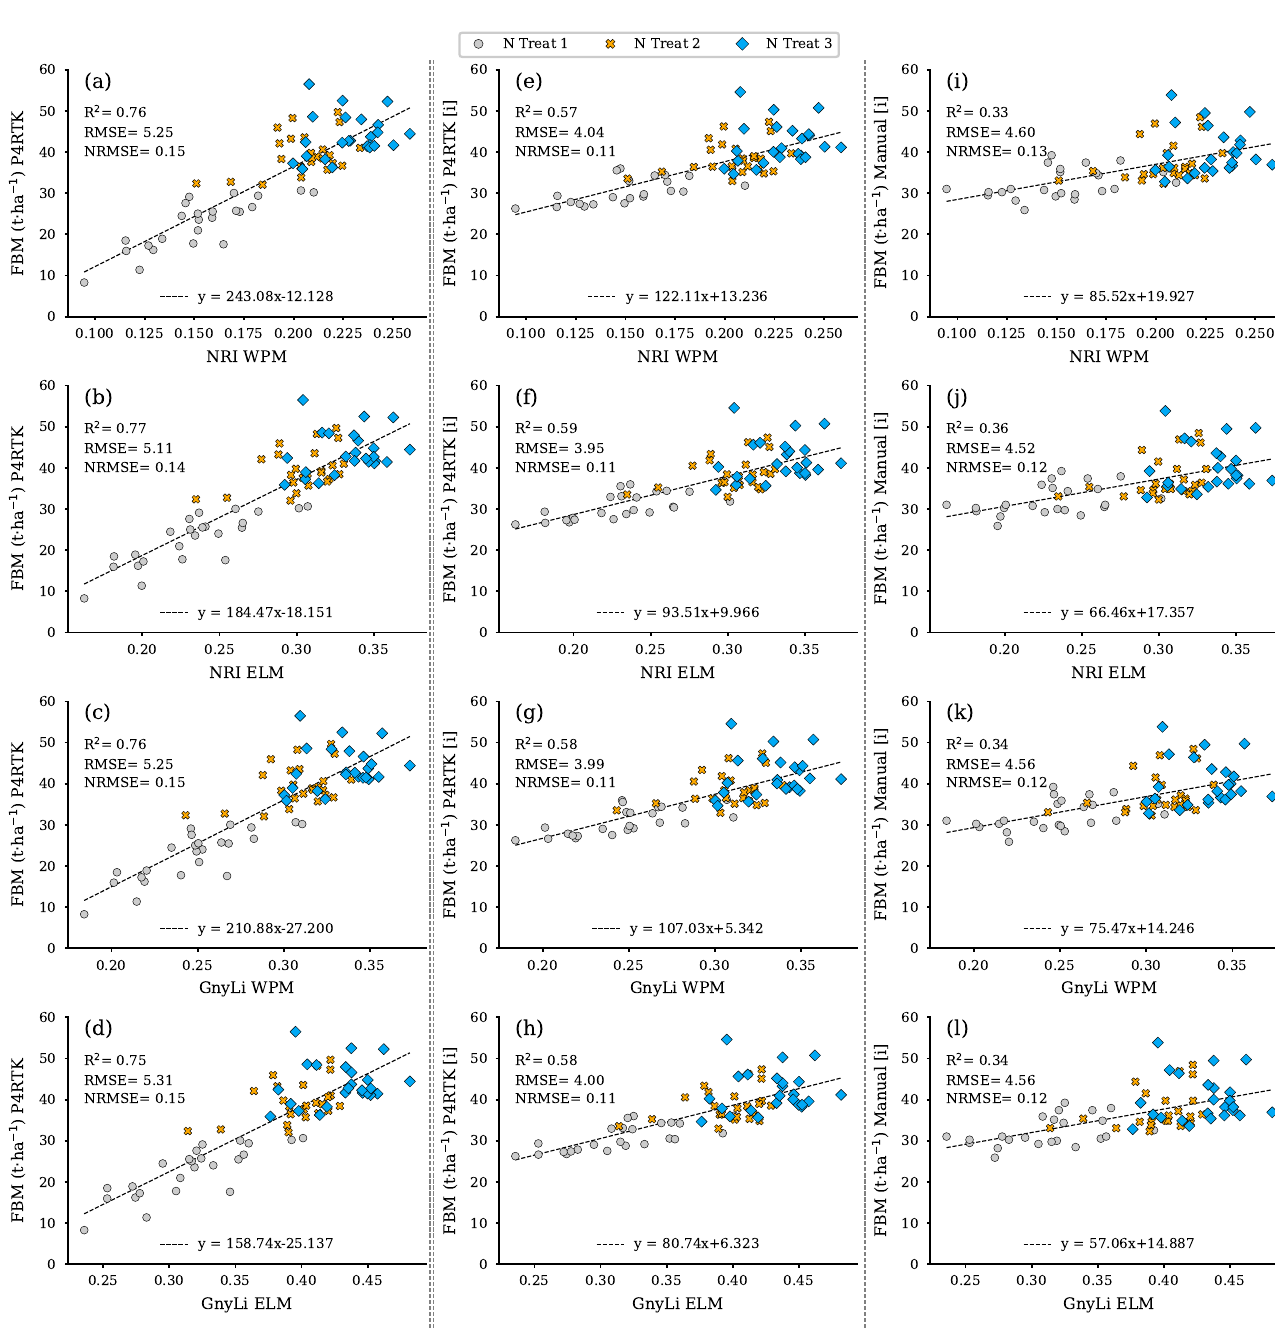
Figure 14. Scatter plots for the fresh biomass (FBM) data estimated for the 72 non-destructive test plots with the FBM-model based on three different crop height data sets with the spectral camera VIs acquired on 2 June. Left column: crop height directly derived from P4RTK RGB data set of 2 June ( a – d ). Center column: linear interpolated crop height from P4RTK RGB data set of 26 May and 12 June ( e – h ). Right column: linear interpolated crop height manually measured on 26 May and 9 June ( i – l ). ( p < 0.001 for all regression